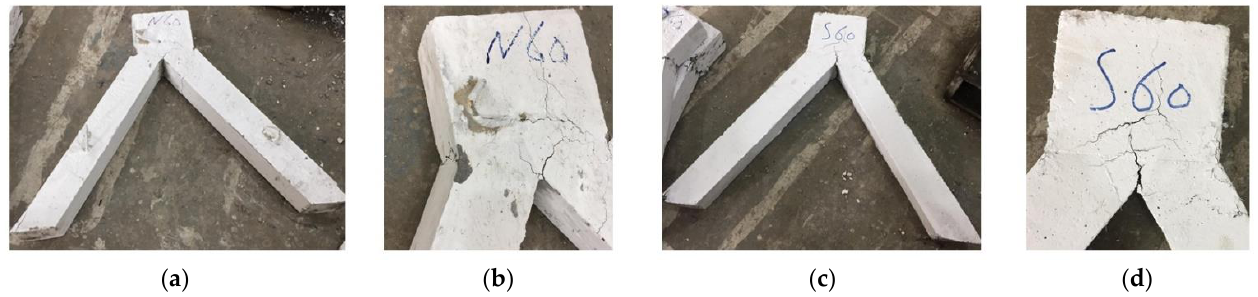
Figure 10. V-shaped columns with 60° angle ( a ) NRC-60, ( b ) NRC-60 failure zone, ( c ) FRC-60, and ( d ) FRC-60 failure zone.